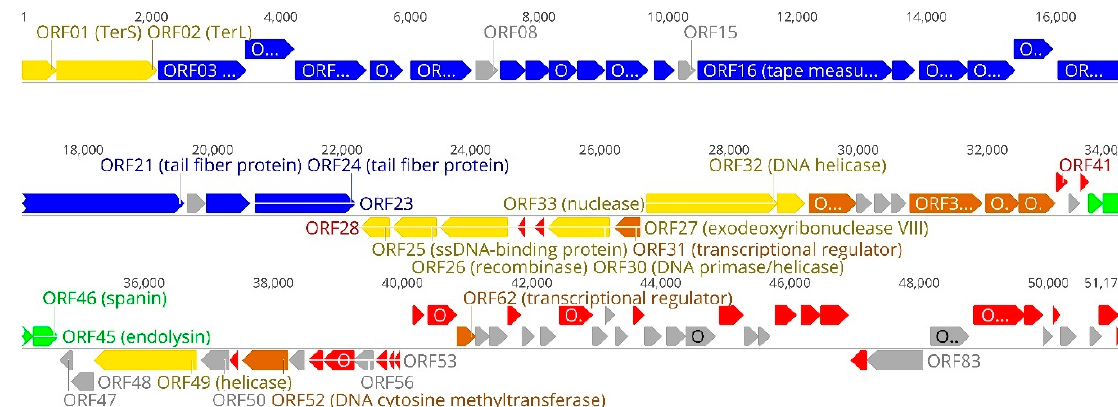
Figure 3. Functional genome map of bacteriophage vB_PagS_AAS23. The coding capacity of the genome is shown. Numbers indicate open reading frame (ORF) position in genome, functions are assigned according to the characterized ORFs in NCBI database and HHpred analysis. The color code is as follows: yellow—DNA replication, recombination, repair and packaging; blue—structural proteins; brown—transcription, translation, nucleotide metabolism; green—lysis, phage-host interaction; grey—conserved hypothetical proteins; red—AAS23 hypothetical proteins with no reliable identity to database entries.